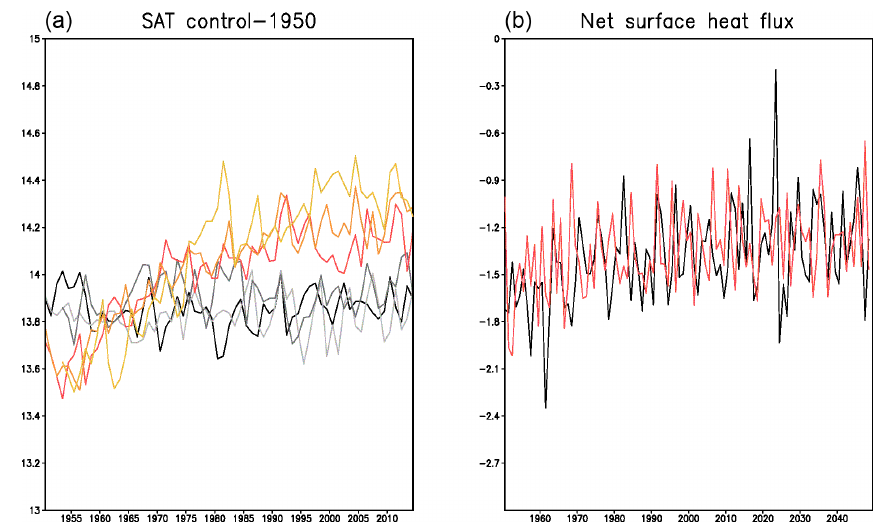
Figure 11. (a) Global mean averaged annual SAT ( ◦ C) in control-1950 for the three members of EC-Earth3P (red colors) and EC-Earth3P- HR (grey colors). (b) Global mean averaged net surface heat flux (Wm − 2 ) in control-1950 of EC-Earth3P (red) and EC-Earth3P-HR (black), displayed only for one member (r1i1p2f1) of each model for clarity; other members display similar behavior.